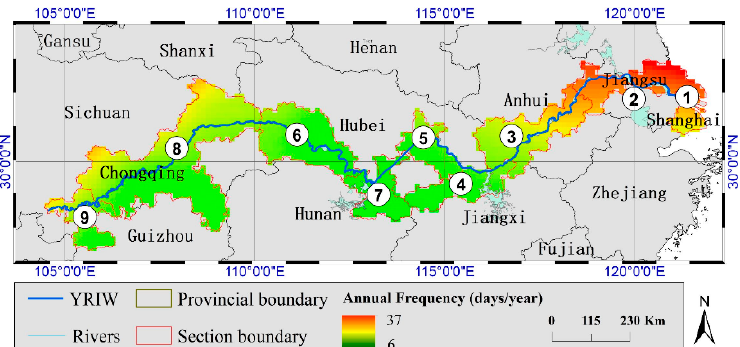
Figure 11. The seasonal frequency of severe climate regions based on the changes in multiple spatial variations in extreme weather phenomena affecting the YRIW.